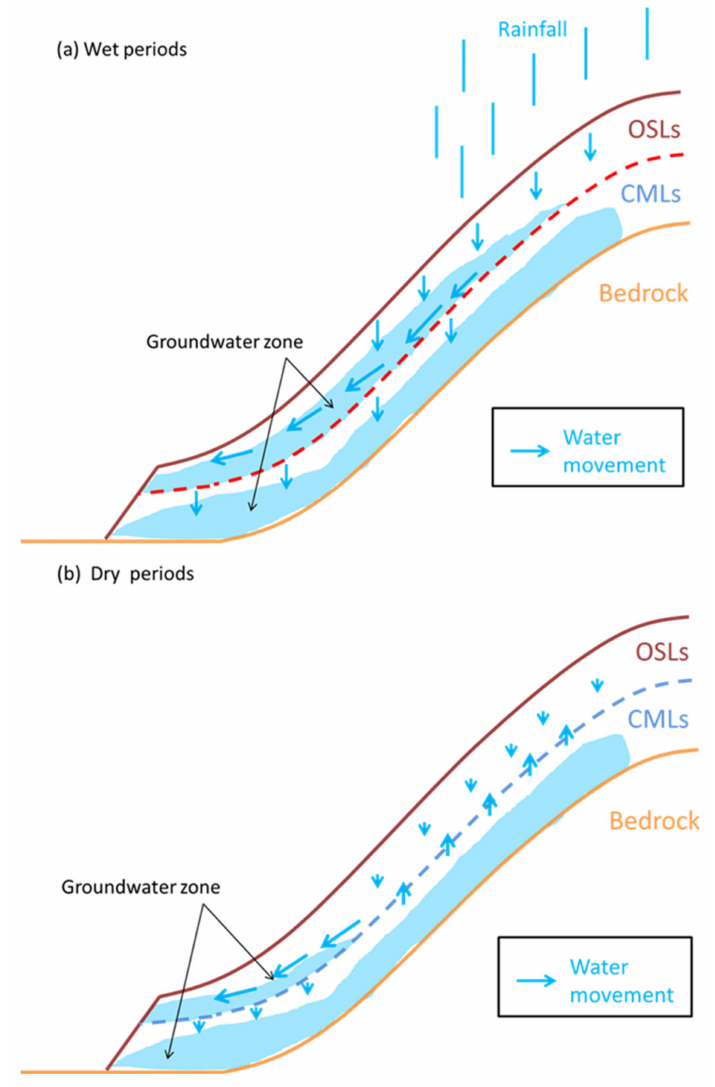
Figure 12. Formation processes of the groundwater zone within the OSLs in the study catchment during ( a ) wet periods and ( b ) dry